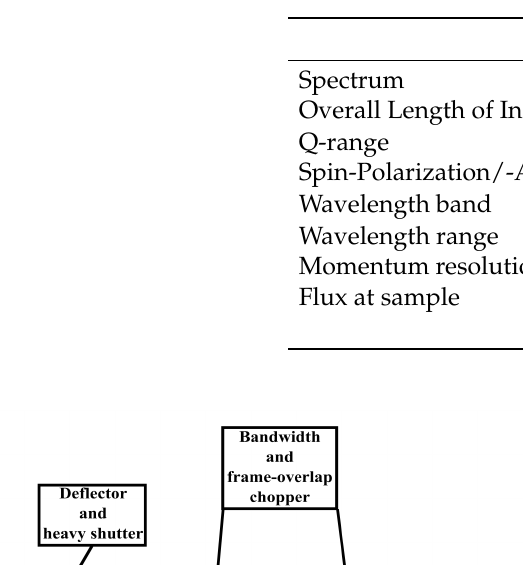
Table 1. Tabulated instrumental parameters for Small-K Advanced DIffractometer (SKADI).